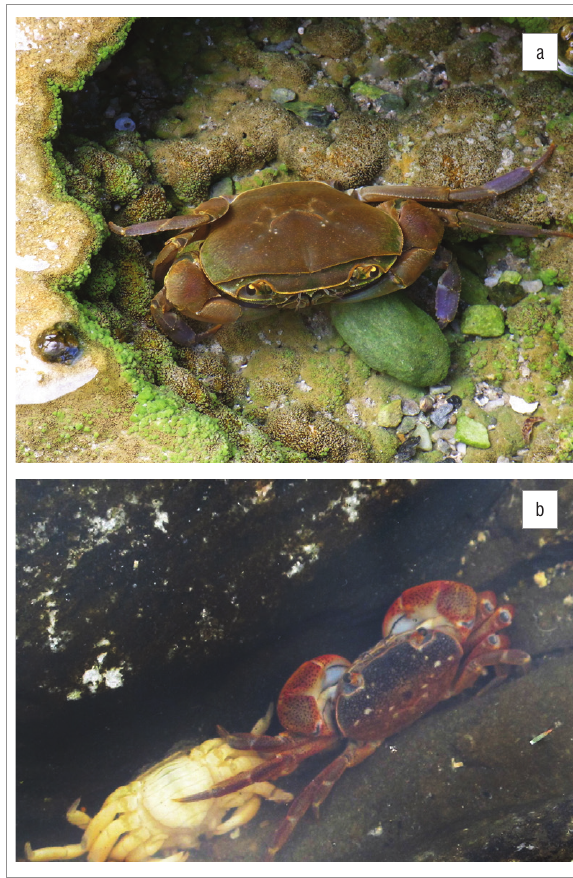
Figure 7: (a) Potamonautes perlatus among stromatolite formations in the upper freshwater layer of the barrage pool and (b) Cyclograpsus punctatus in the deeper layer of the barrage pool, with individuals dying of osmotic stress as freshwater seepage inflow increases and salinity decreases (photos: Lynette Clennell, Schoenmakerskop, 6–13 October